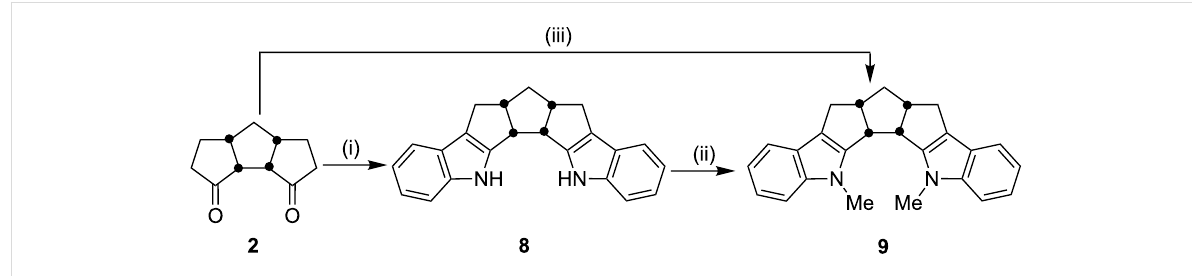
Scheme 2: Synthesis of the diindole derivative 9 Reagents and conditions: (i) TA:DMU, PhNHNH 3 Cl, 70 °C, 6 h, 62%; (ii) NaH, MeI, DMF, rt, 24 h, 87%; (iii) TA:DMU, 70 °C, PhNMeNH 2 , 6 h, 76%.